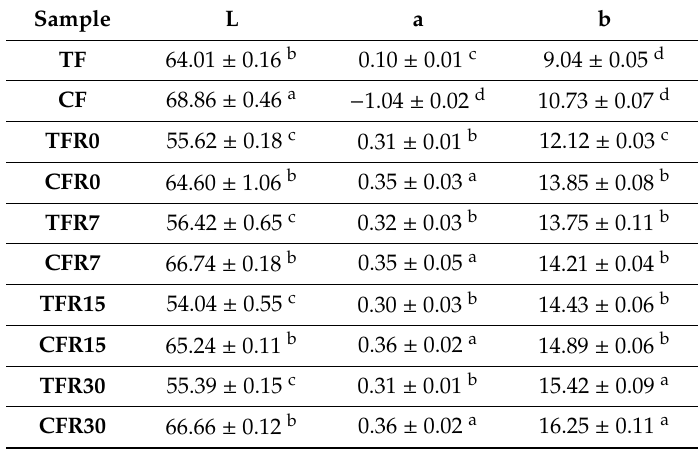
Table 3. Color of traditional and industrial (commercial) nixtamalized corn flours and corn tortilla flours. Sample L